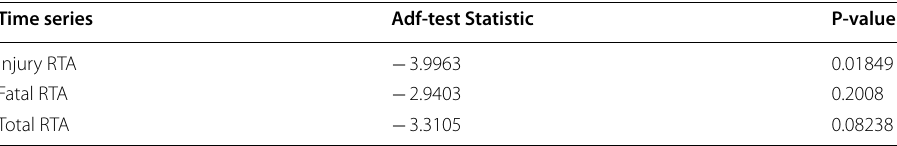
Table 4 Summary statistics for ADF test of stationarity